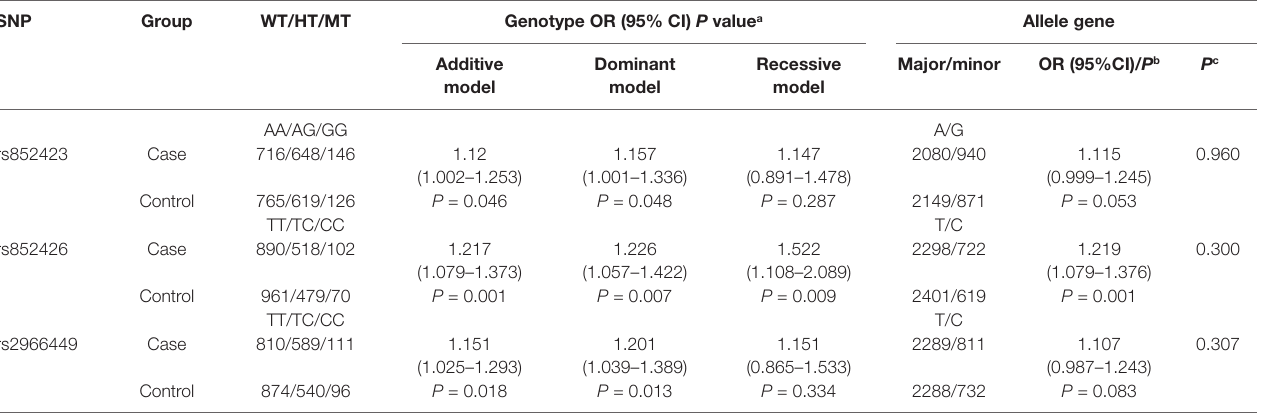
TABLE 2 | Association analysis of SNPs of the ACTB gene with